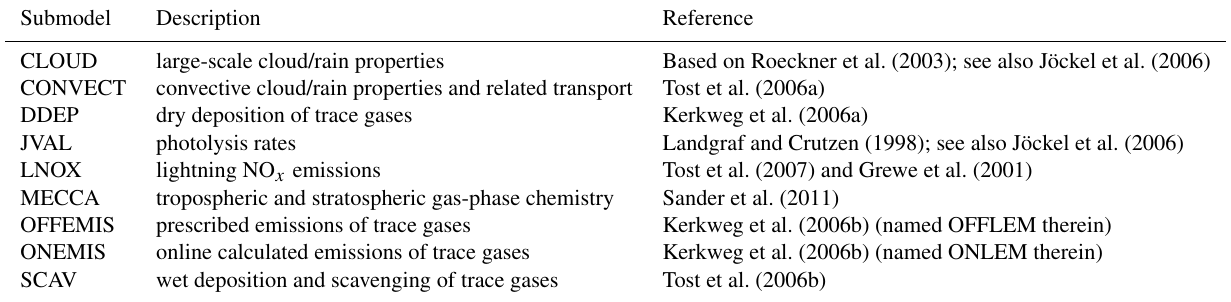
Table 1. Brief description of the submodels used together with the TAGGING submodel. A complete list can be found in the supplement of Mertens et al. (2016).